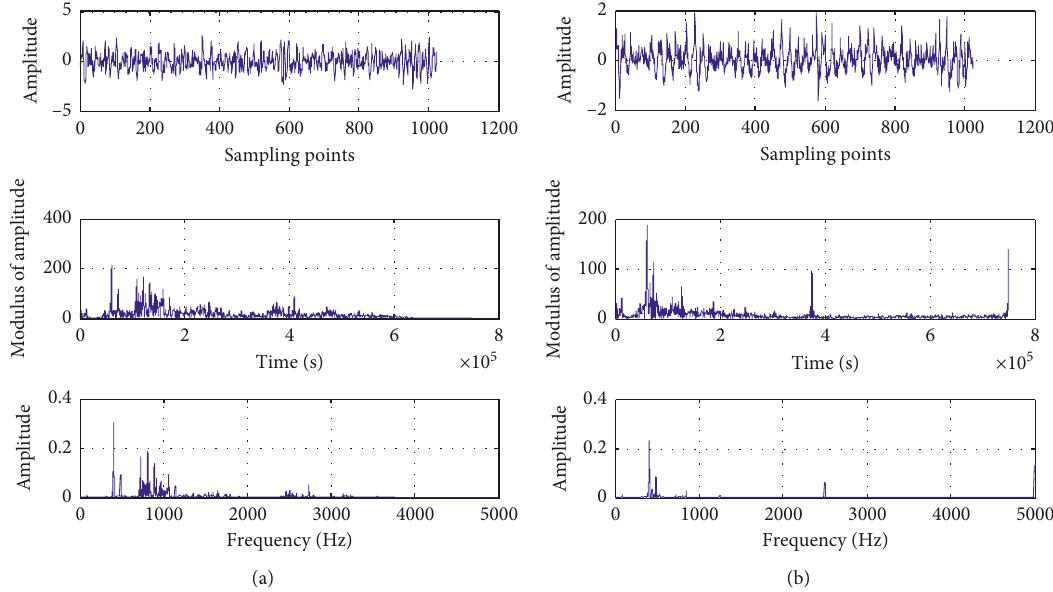
Figure 15: (a) Normal operation signal, normal operation of Fourier transform, and power spectral density plot; (b) denoising signal, Fourier transform, and power spectral density plot after improving